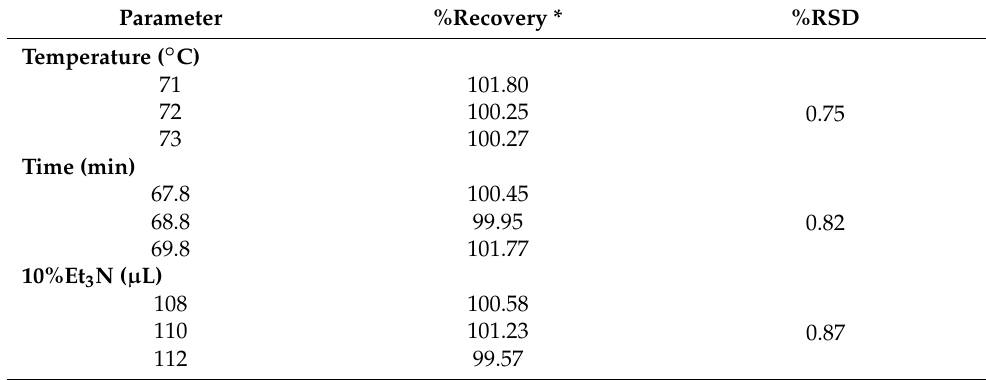
Table 4. Robustness testing results of 100% concentration level (5 µ